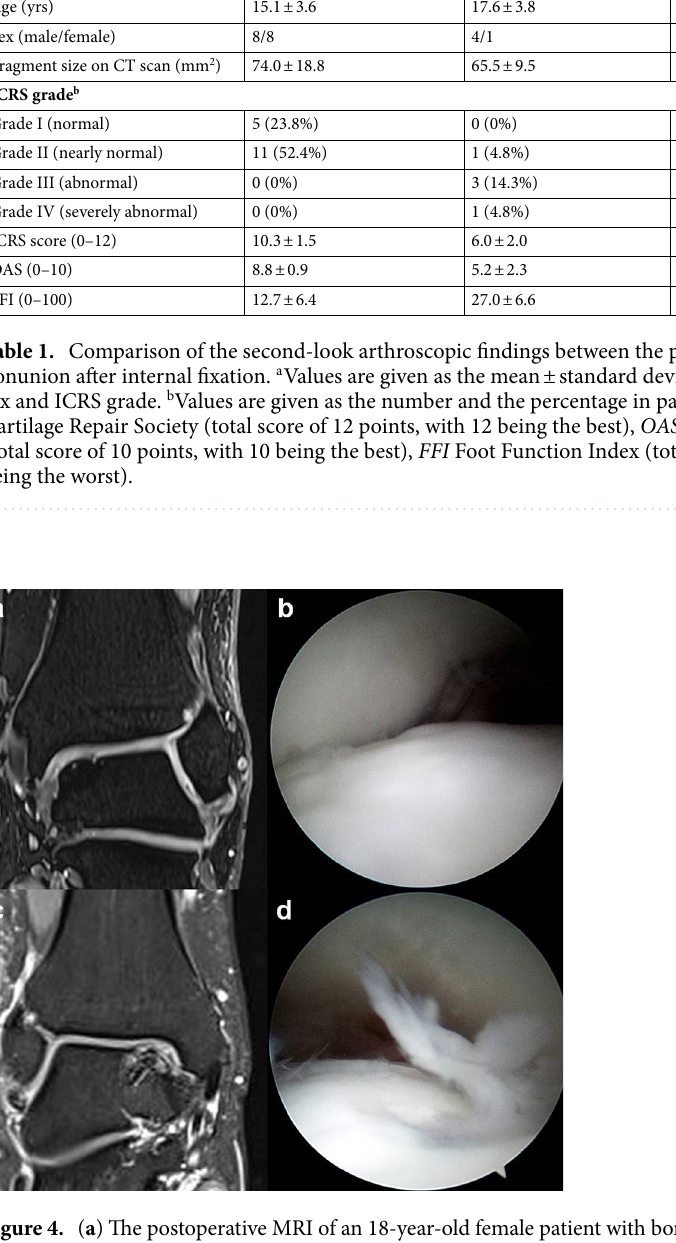
Figure 4. ( a ) The postoperative MRI of an 18-year-old female patient with bone fragment union shows normal congruity of the fixed osteochondral fragment without any cysts underneath the fragment. ( b ) The second- look arthroscopic image shows smooth, pearly, hyaline-like cartilage of the osteochondral fragment, which is well integrated with surrounding cartilage. ( c ) The postoperative MRI of a 21-year-old male patient with bone fragment nonunion shows incongruity of the fragment with irregular cartilage and cyst underneath the fragment. ( d ) The second-look arthroscopic image shows severe fibrillation and flap tearing of the